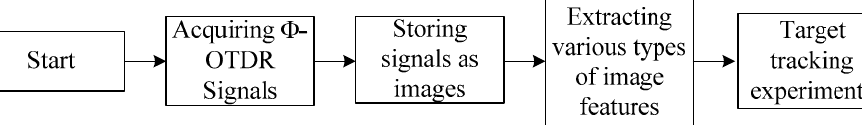
Figure 1. Steps of the proposed method.